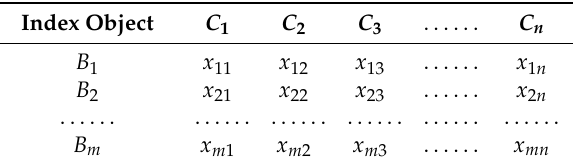
Table 3. Structure of the evaluation